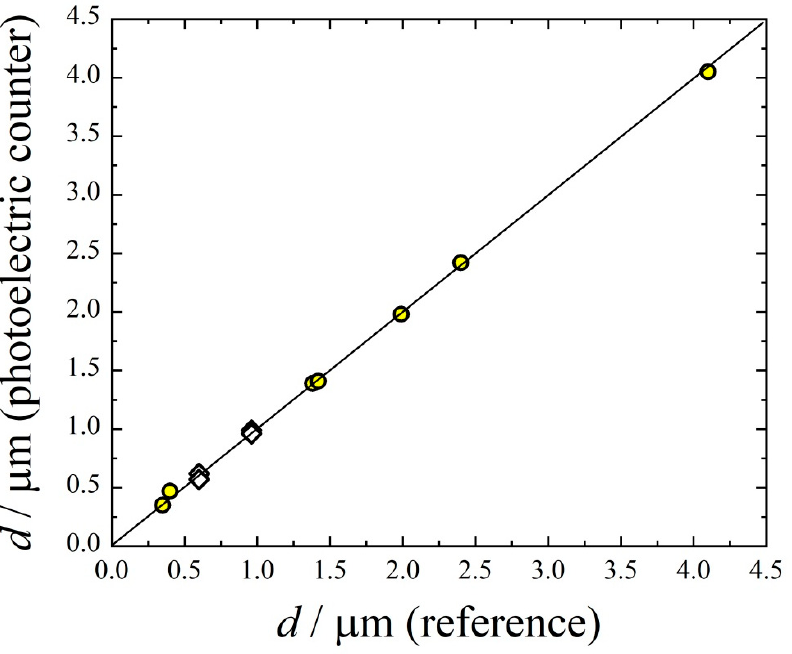
Figure 2. Mutual correspondence of mean diameters measured by the photoelectric counter and by the gravity settling technique (circles). Diamonds—monodispersed polystyrene latex spheres. Solid line is one-to-one correspondence.